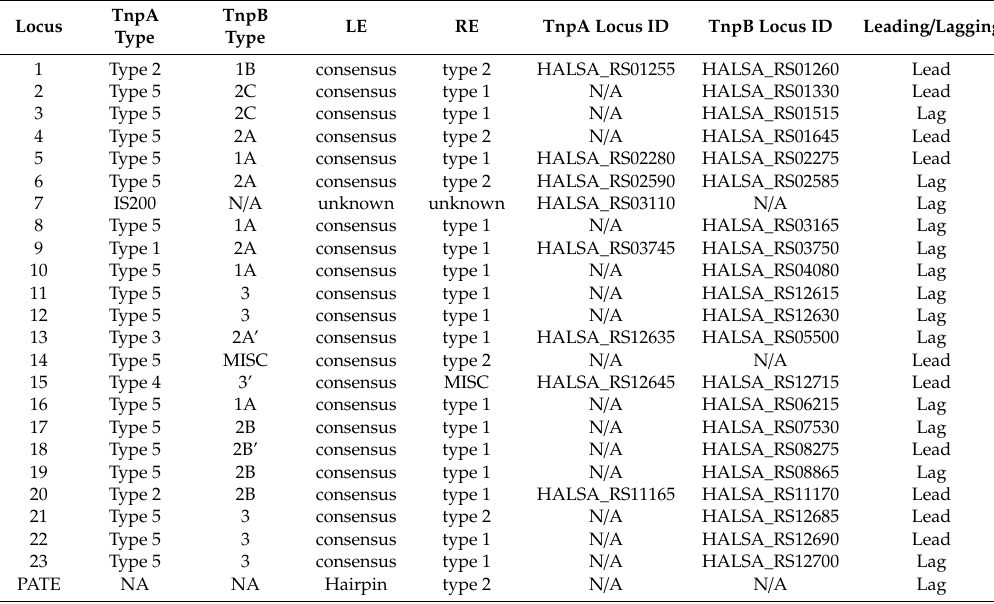
Table 1. Characteristics of IS200 and IS605